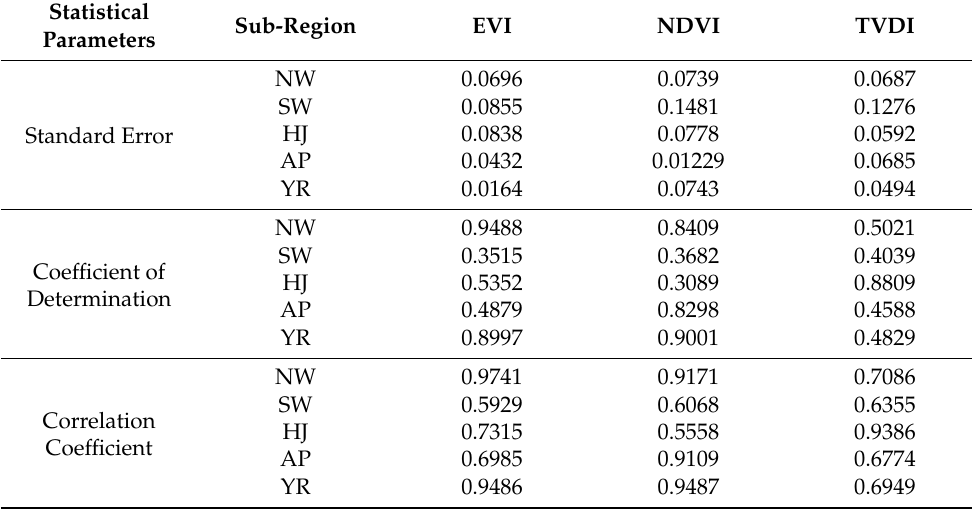
Table 3. Statistical parameters of fitting vulnerability curves of five